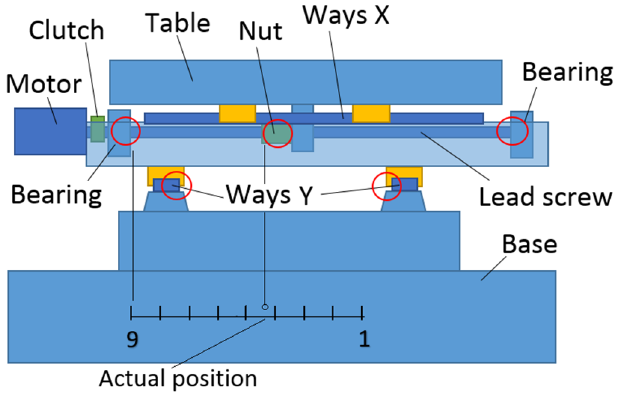
Figure 1. Diagram of the kinematic chain of the cross table with critical contact points marked with a circle.